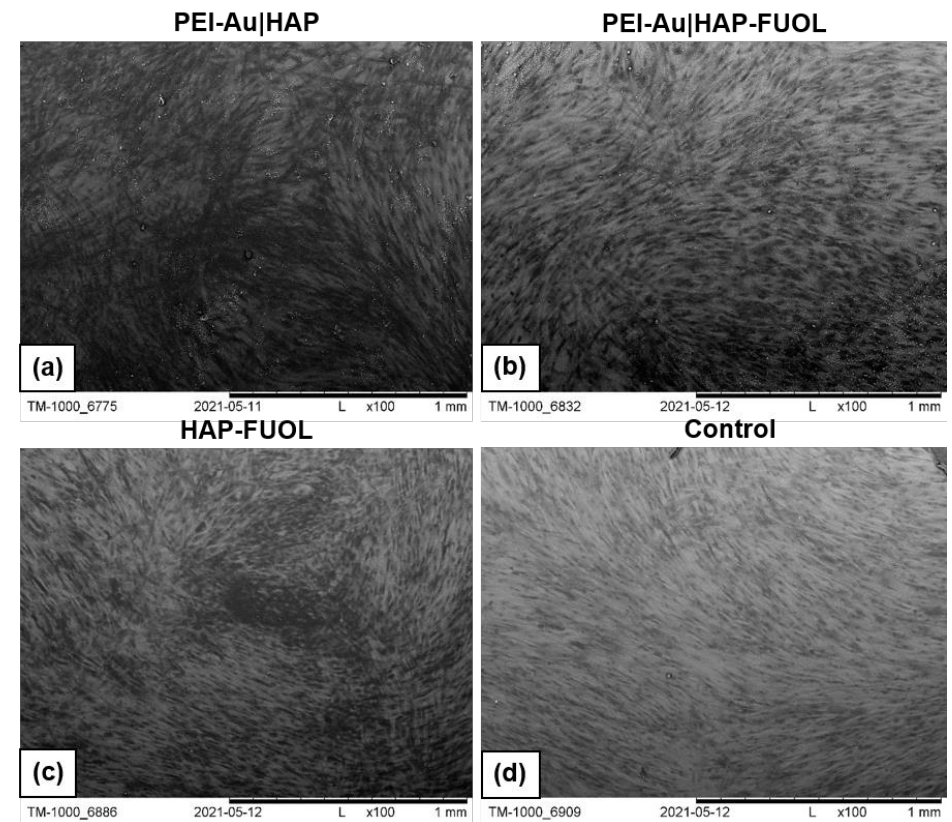
Figure 9. SEM visualization of HDF cells immobilized within designed scaffolds after 10-day culture. Key to the symbols : ( a ) PEI-Au|HAP: bilayer consisting of polyethylenimine with AuNPs incorporating and hydroxyapatite; ( b ) PEI-Au|HAP-FUOL bilayer consisting of polyethylenimine with AuNPs incorporating and hydroxyapatite with FUOL incorporating; ( c ) HAP-FUOL: hydroxyapatite with FUOL incorporating; ( d ) Control: cells cultured on glass slides without the membranes. Magnification ×100.